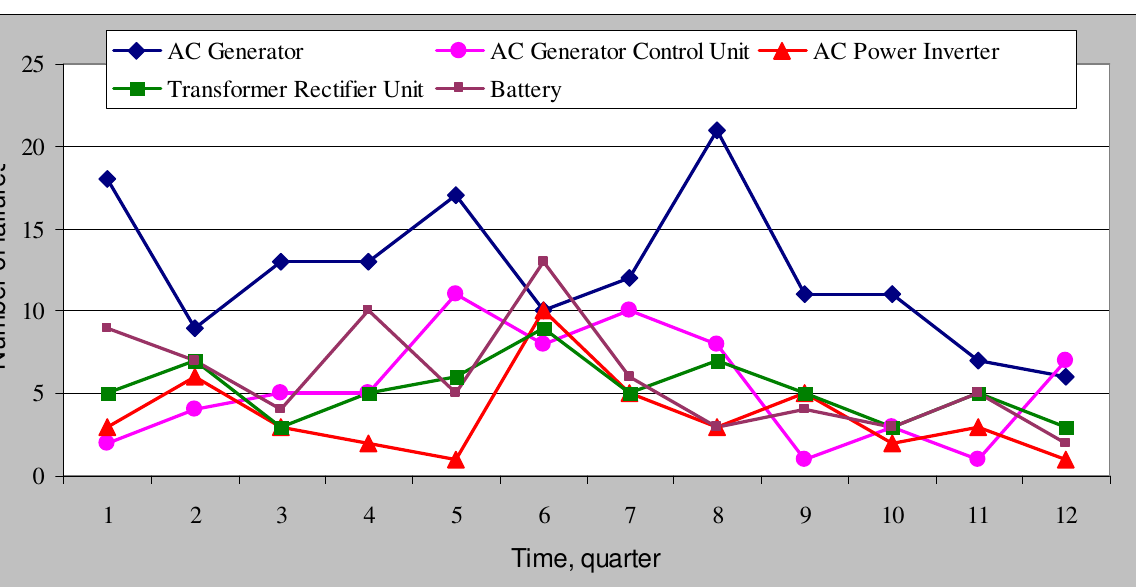
Fig 2. Diagram of failures of electrical system of an aircraft